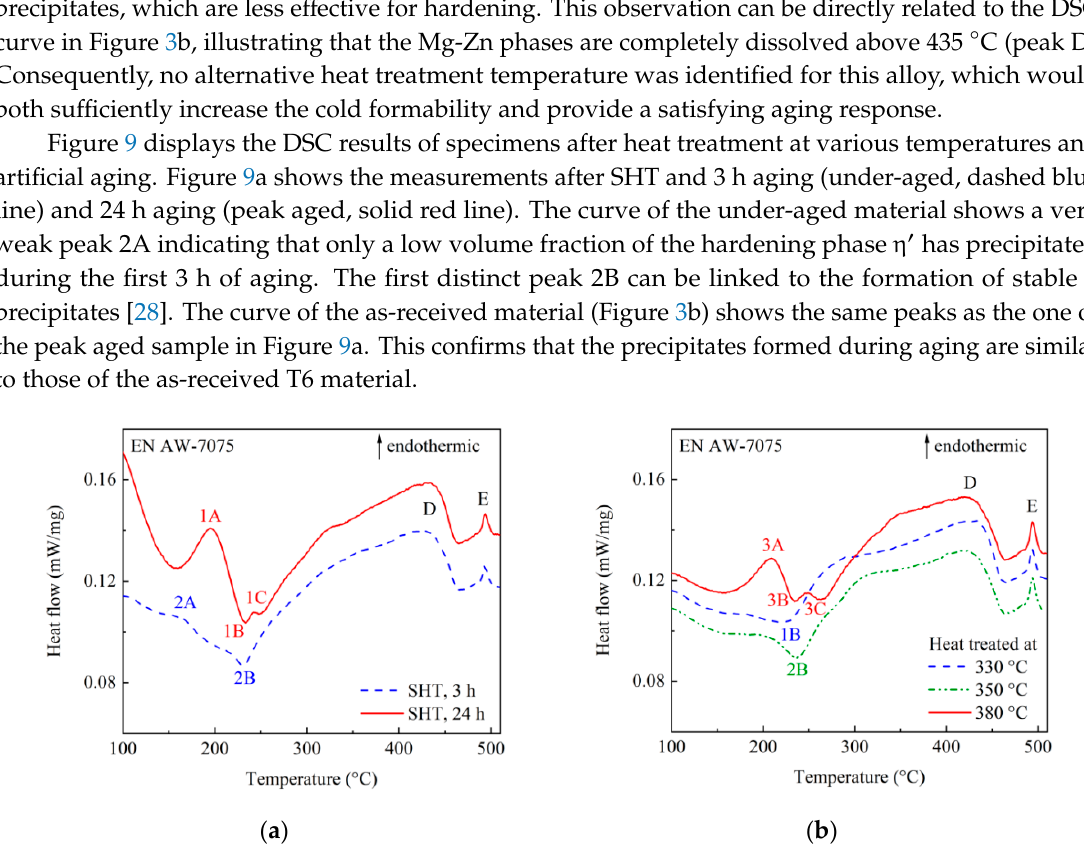
Figure 9. DSC curves for EN AW-7075 at a heating rate of 10 K / min. ( a ) After SHT and aging for 3 h and 24 h, ( b ) after retrogression at various temperatures and aging for 24 h.